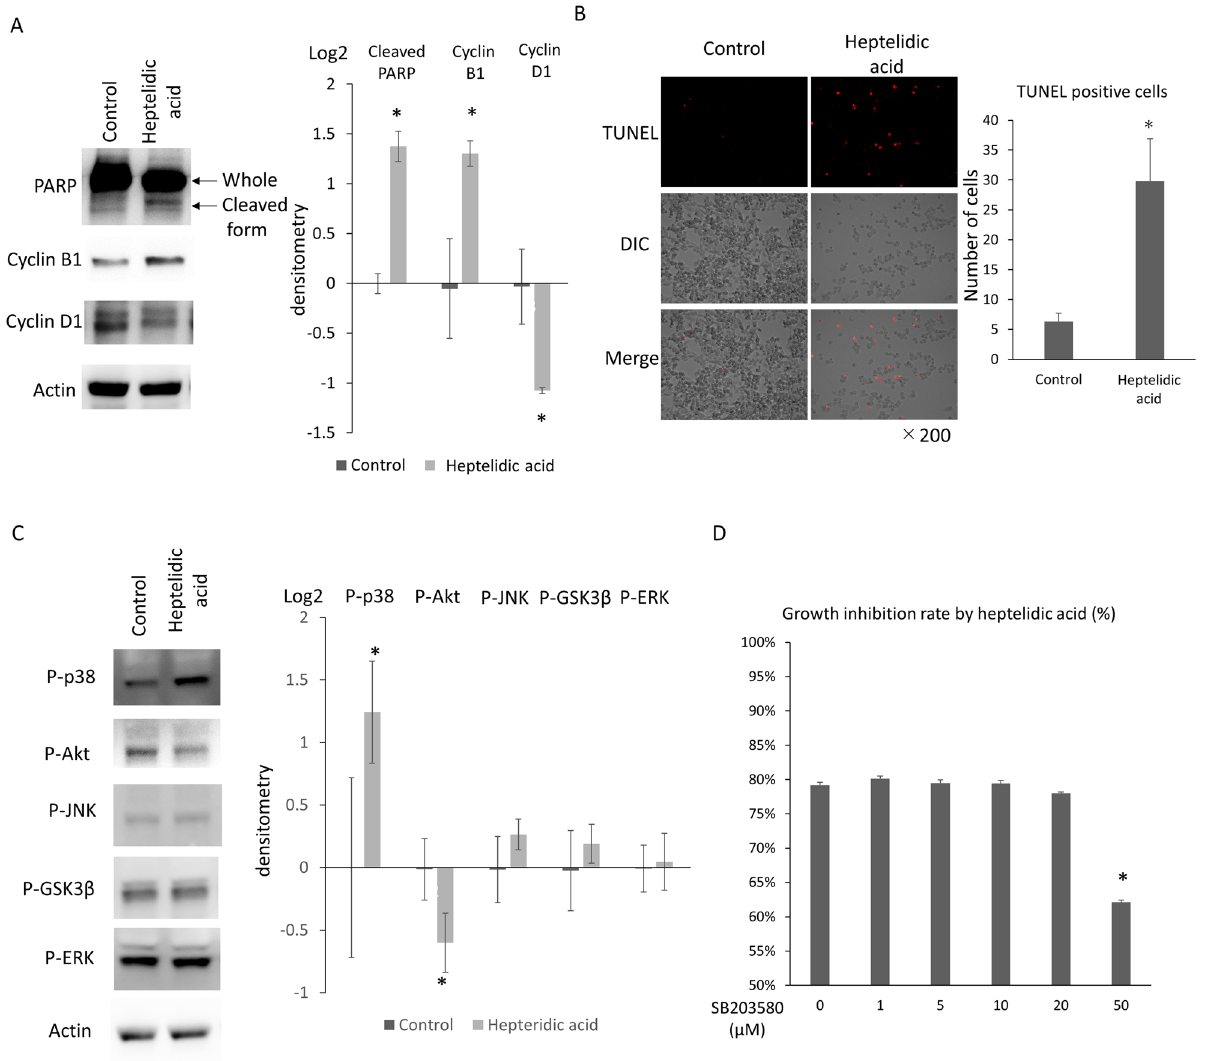
Figure 5. Heptelidic acid exerted anti-tumor effects mediating the p38 MAPK signaling pathway in pancreatic cancer cells. A Western blotting analysis indicated that the expression of cleaved PARP and cyclin B1 was increased, and that of cyclin D1 was decreased in SUIT-2 cells by treatment with 1 μg/mL of heptelidic acid ( A ). TUNEL staining showed that the DNA fragmentation of SUIT-2 cells was induced by treatment with 1 μg/mL of heptelidic acid ( B ). Western blotting showed that the phosphorylation of p38 MAPK was augmented while that of Akt was attenuated by treatment with 1 μg/mL heptelidic acid ( C ). The SRB assay showed that the growth inhibition rate of heptelidic acid was decreased by treatment with SB203580 ( D ). The error bars show the standard deviation (S.D.) ( A ; p-p38; n = 6, p-Akt, p-JNK, p-GSK3β, p-ERK; n = 3) ( C , D ; n = 3) ( B ; n =